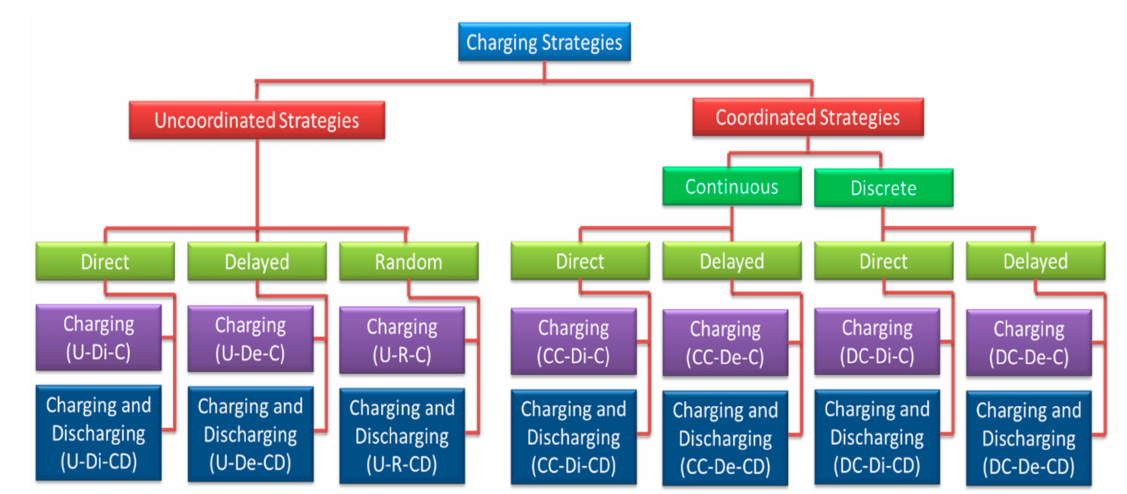
Figure 1. Coordinated and Uncoordinated